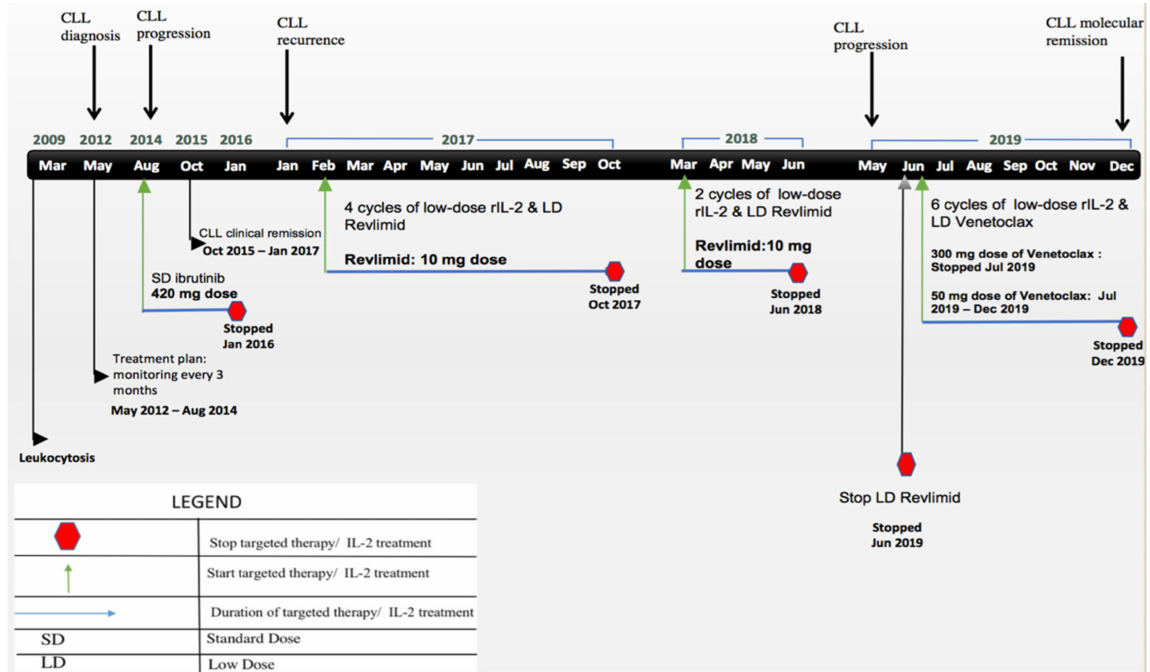
Figure 1. Key timeline information. The black arrow indicates time of CLL diagnosis and progress. Green arrow indicates treatment initiation. Patient went on and off treatments. In August 2014, ibrutinib treatment was started at 420 mg once daily. In February 2017, immunotherapy consisted of daily low-dose subcutaneous rIL-2 injections of 10–20,000 IU/kg for 5 days per week in addition to oral low dose lenalidomide 10 mg per day. In March 2018, two cycles of low-dose rIL-2. In June 2019, immunotherapy consisted of low-dose subcutaneous rIL-2 injections and low-dose venetoclax 50 mg per day. Blue arrows indicate the length of treatment. Red octagons indicate when the patient would stop treatment. Table 1. Results of FISH, abnormal CLL cells, and IGHV mutation status changes in response to treatment. Date of Visit FISH 13q14.3 (Normal <